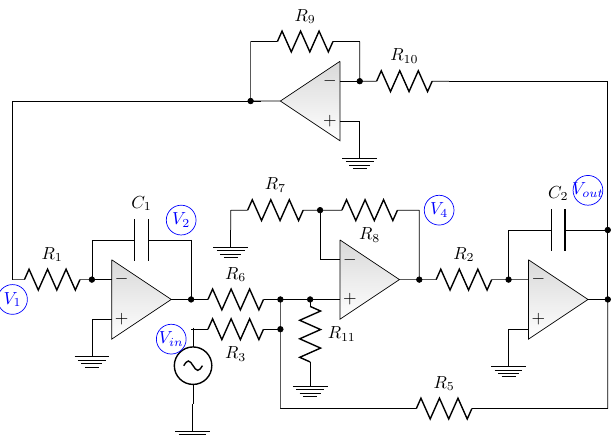
Figure 1. Biquadratic bandpass filter implemented with four opamps, ten resistors, and two capacitors.